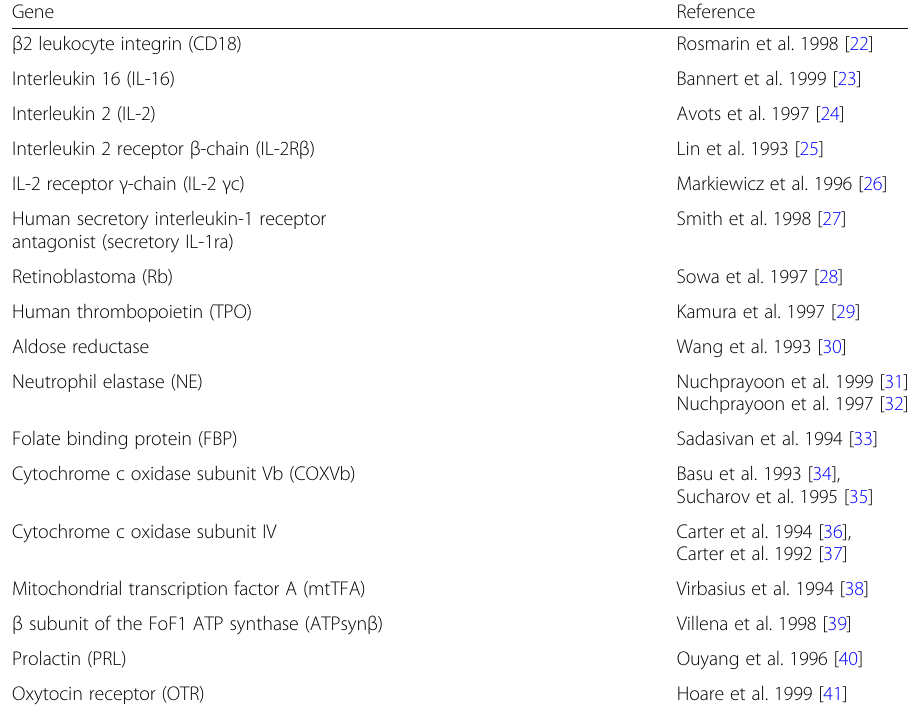
Table 1 List of some human genes that bind the GABP (cid:129) p300/CBP transcription complex Gene Reference β 2 leukocyte integrin